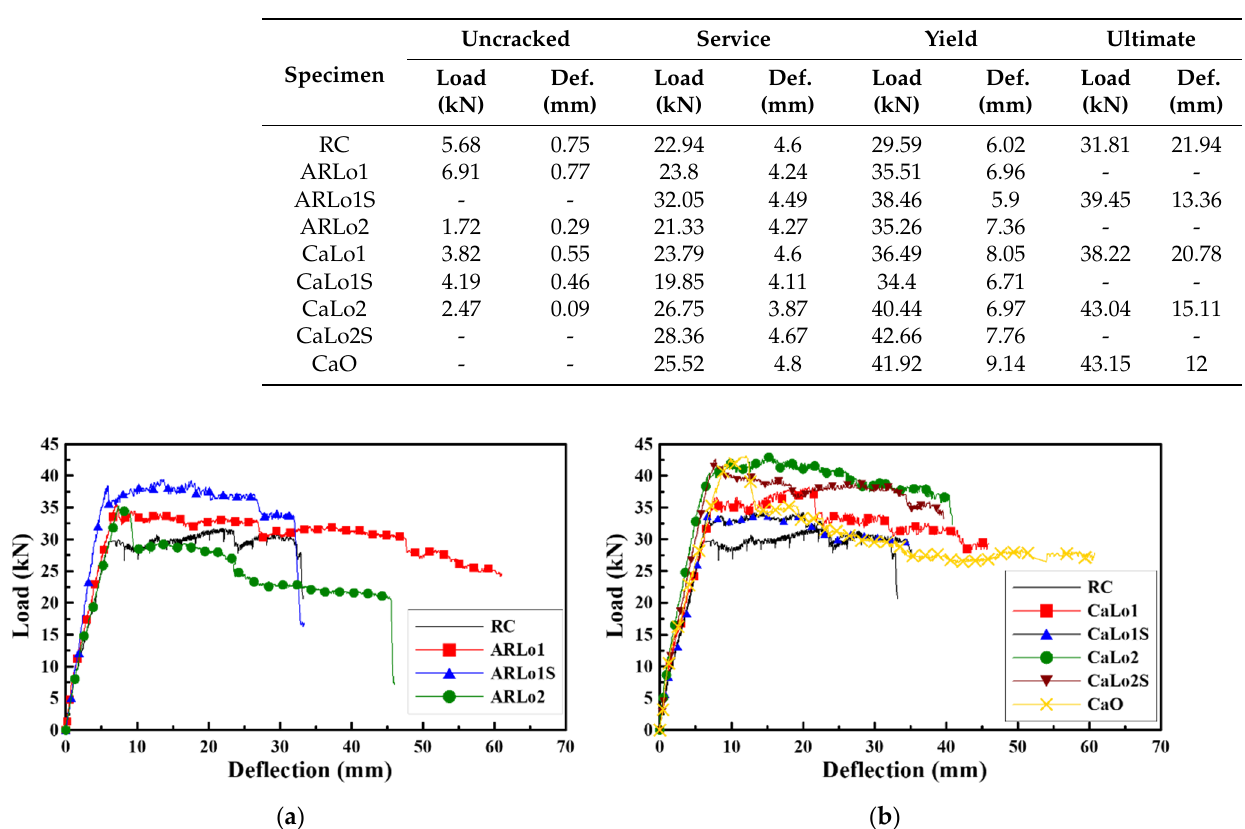
Table 6. Experimental results of load and deflection.